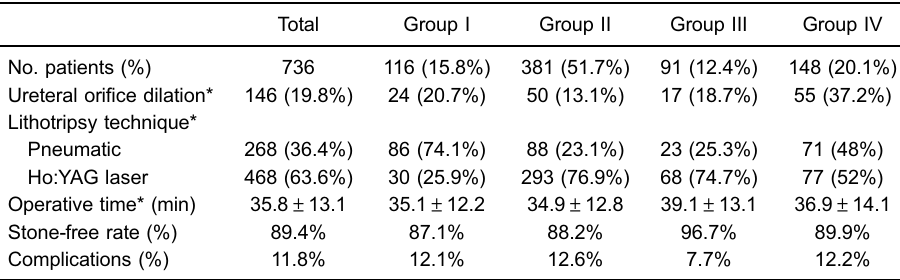
Table 2. Operative characteristics of the